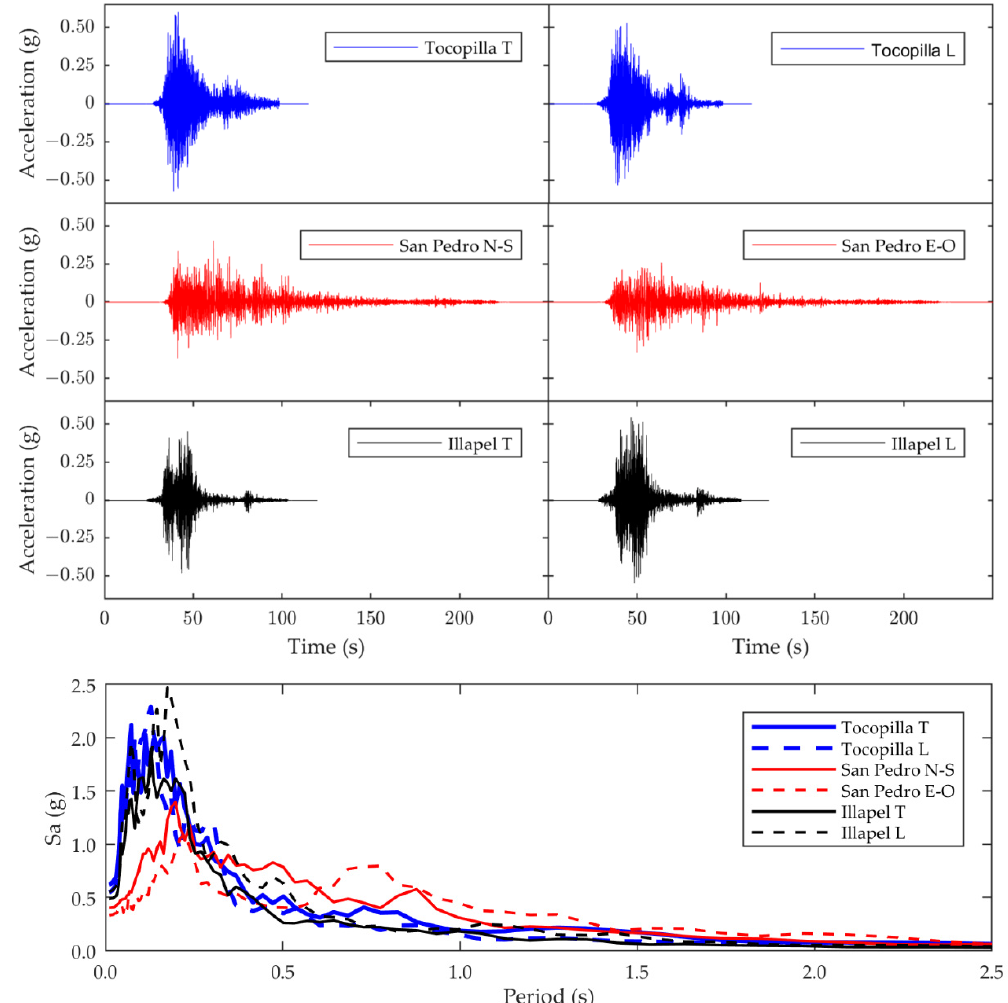
Figure 6. Seismic demands used in the incremental dynamic analyses.